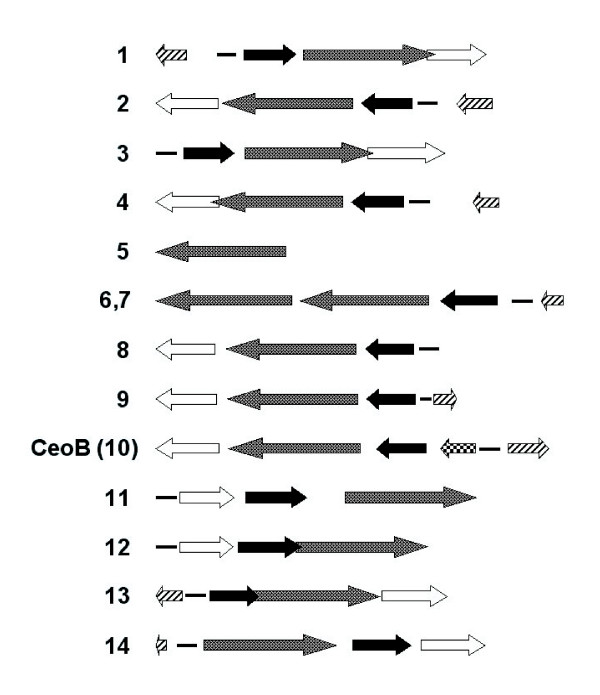
Proposed RND efflux pump encoded by B. cenocepacia genome. The organization of the RND efflux pump genes identified in B. cenocepacia genome was achieved by bioinformatic tools as described in Methods. RND transporter-encoding genes are depicted as grey arrows (orf1–orf14), outer-membrane factor-encoding genes as white arrows, periplasmic membrane fusion protein-encoding genes as black arrows, and regulatory genes as arrows with stripes. Black lines indicate the regions of Stress-Induced DNA duplex Destabilization that could be associated with promoters. Genes encoding protein components of CeoAB-OpcM (6) are indicated as white arrow (opcM), grey arrow (ceoB), black arrow (ceoA); arrows with stripes and squares indicated the ceoR and llpE genes encoding a regulator and a putative periplasmic lipase-like protein, respectively.